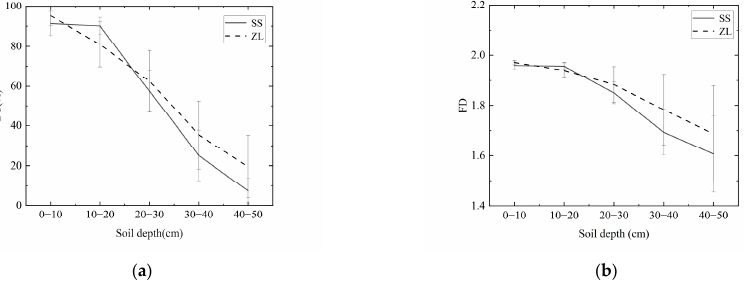
Figure 3. Change trend of DC and FD with increasing soil depth in the two sites: ( a ) Change trend of DC with increasing soil depth; ( b ) Change trend of FD with increasing soil depth.